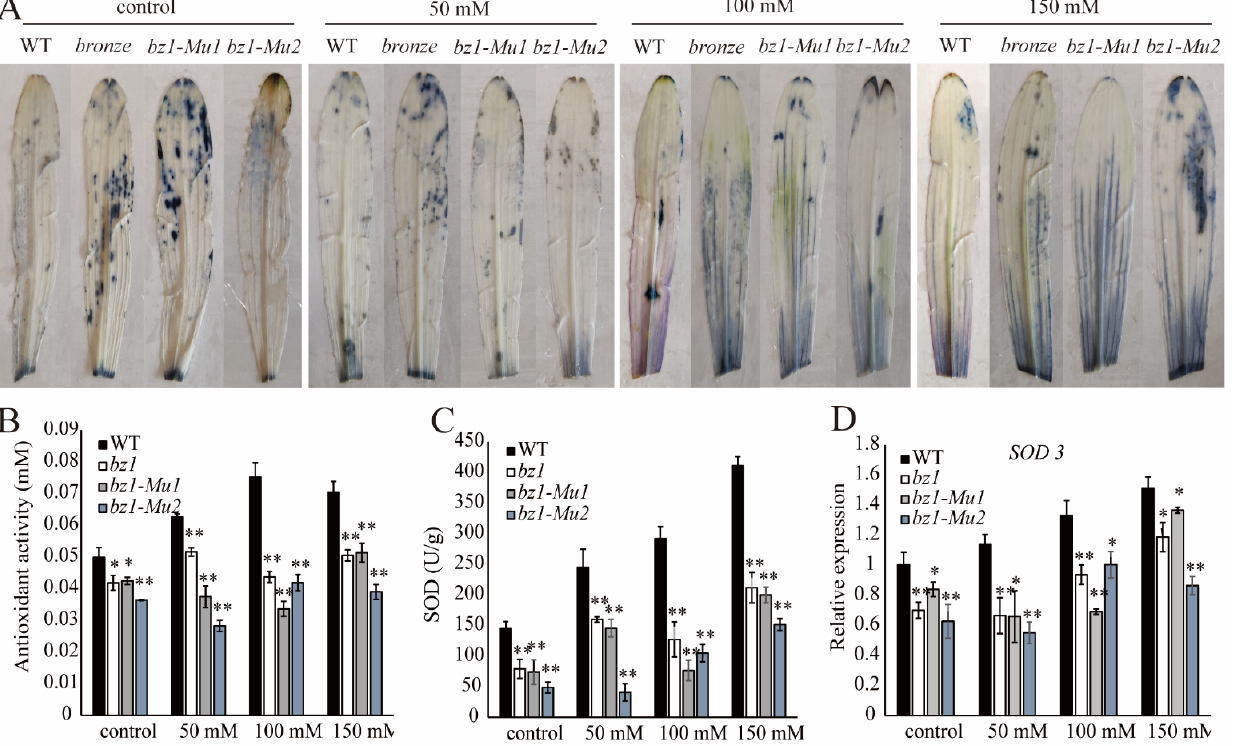
Figure 7. Antioxidant activity conferred by ZmBZ1 and enhanced under salinity stress. NBT staining ( A ), Antioxidant activity ( B ), SOD activity ( C ) and SOD3 expression ( D ) of three bz1 alleles and WT seedlings at 14 DAS before and after NaCl treatment. GAPDH was used as an internal control. Values are shown as means ± SE, n = 3. Asterisks indicate significant differences relative to the WT (Student’s t -test: * p < 0.05; ** p < 0.01).